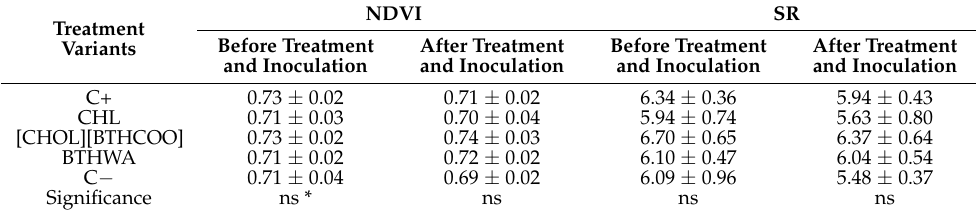
Table 4. Measured Vegetation indices (VIs) in the study. NDVI SR Treatment Before Treatment After Treatment Before Treatment Variants and Inoculation and Inoculation and Inoculation